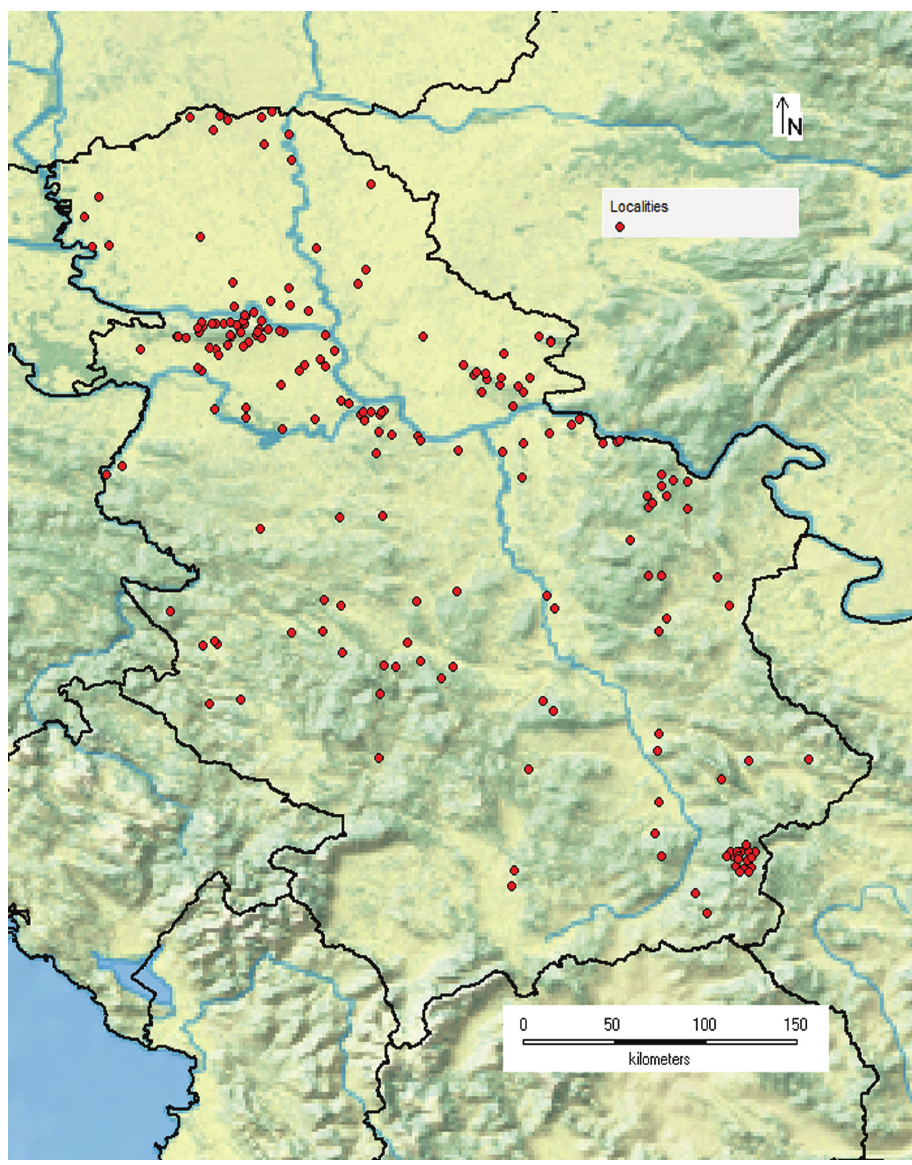
Figure 1. Map of Serbia showing the locations where specimens were